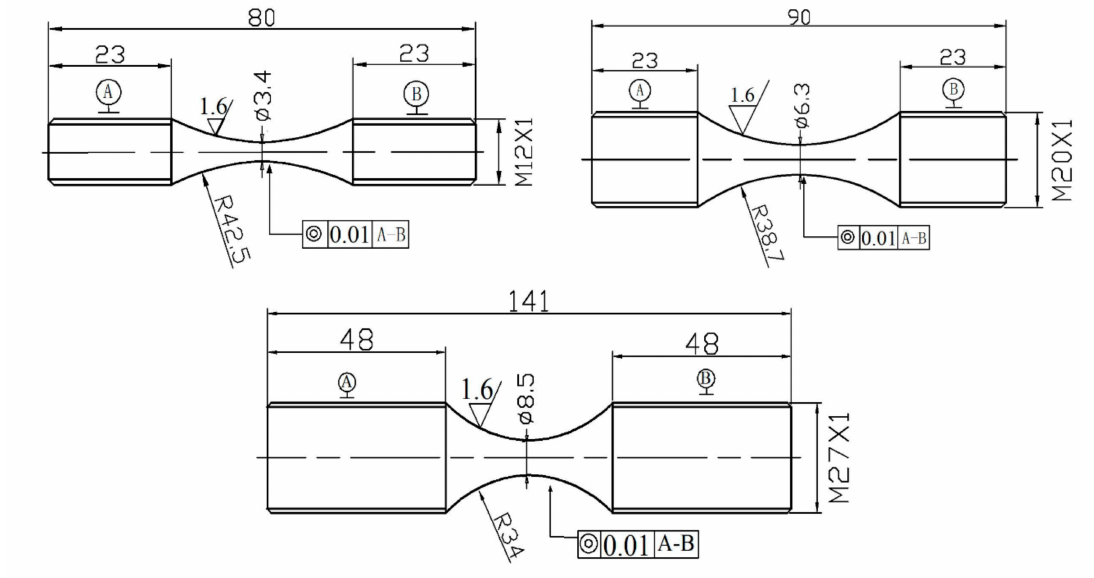
Figure 1. Geometry of fatigue test specimens (units: